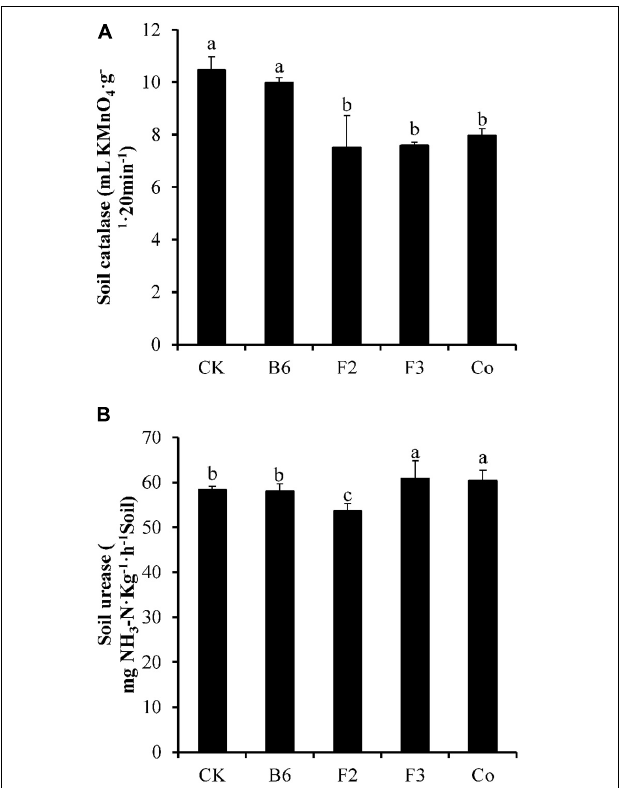
FIGURE 3 | Effects of microbial inoculation on antioxidant enzyme activity of the soil. CK, uninoculated; B6, Bacillus sp.; F2, Clonostachys rosea ; F3, Aspergillus niger ; Co, Co-inoculation with Bacillus sp. and Aspergillus niger . (A) Soil catalase and (B) soil urease. Different letters indicate that the values significantly differed at p < 0.05. The values represent the mean ± SD ( n = 4).